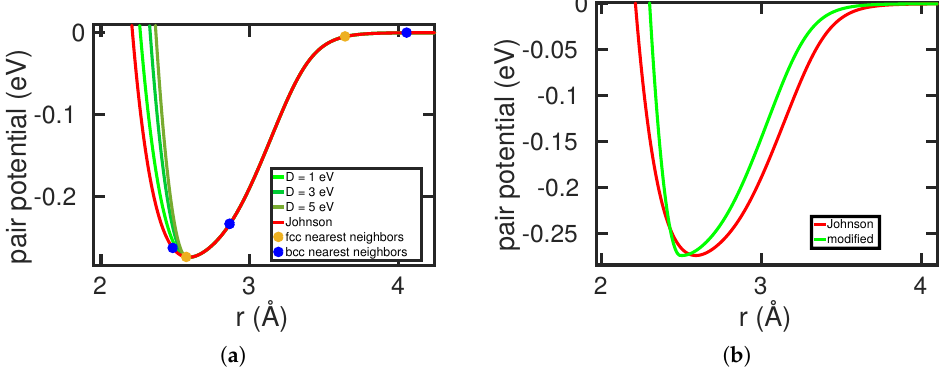
Figure A1. Modification of the Johnson potential [25] for the Fe–Fe interaction, Equation (A5). ( a ) Effect of the modification parameter D . The nearest-neighbor positions in bcc and fcc Fe are marked. ( b ) Comparison of the original with the modified Johnson